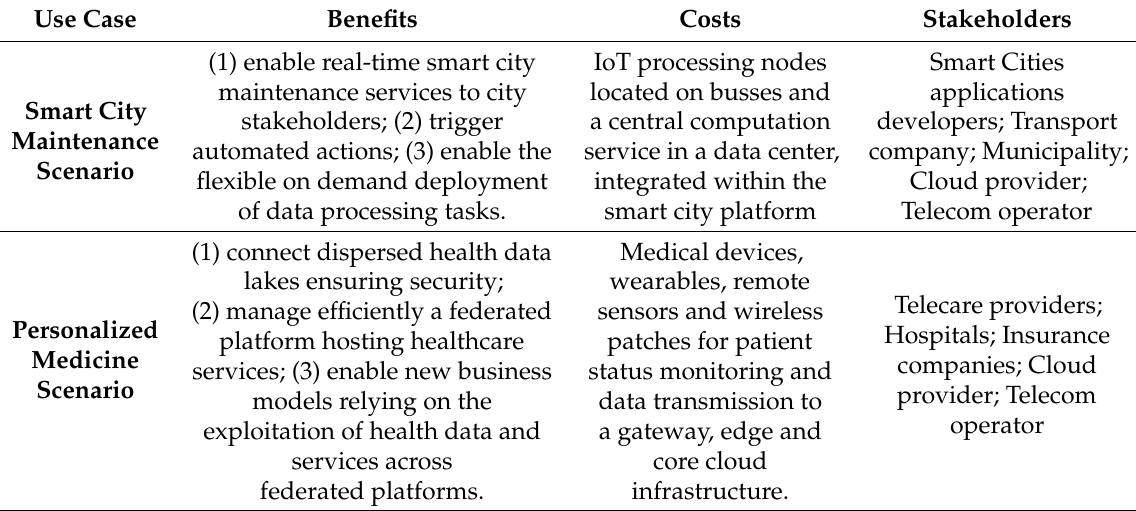
Table 2. Example use cases associated with expected benefits, costs and